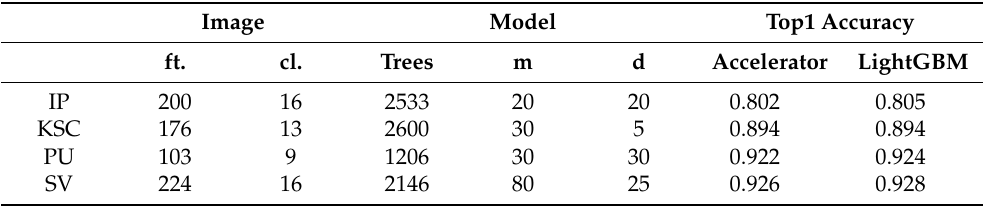
Table 1. Datasets and model